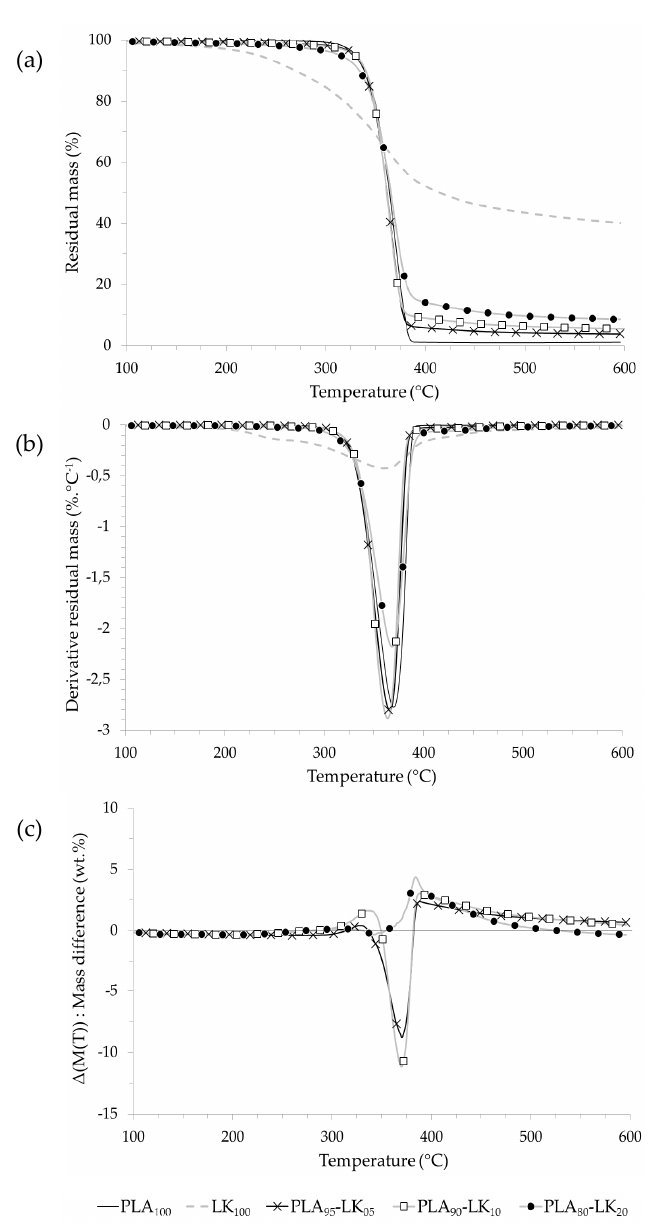
Figure 3. ( a ) Thermogravimetric (TG); ( b ) derivative thermogravimetric (DTG); and ( c ) mass difference curves of PLA-LK composites. Table 5. Thermogravimetry data of PLA, LK, AP, PLA-LK, PLA-AP and PLA-LK-AP samples.